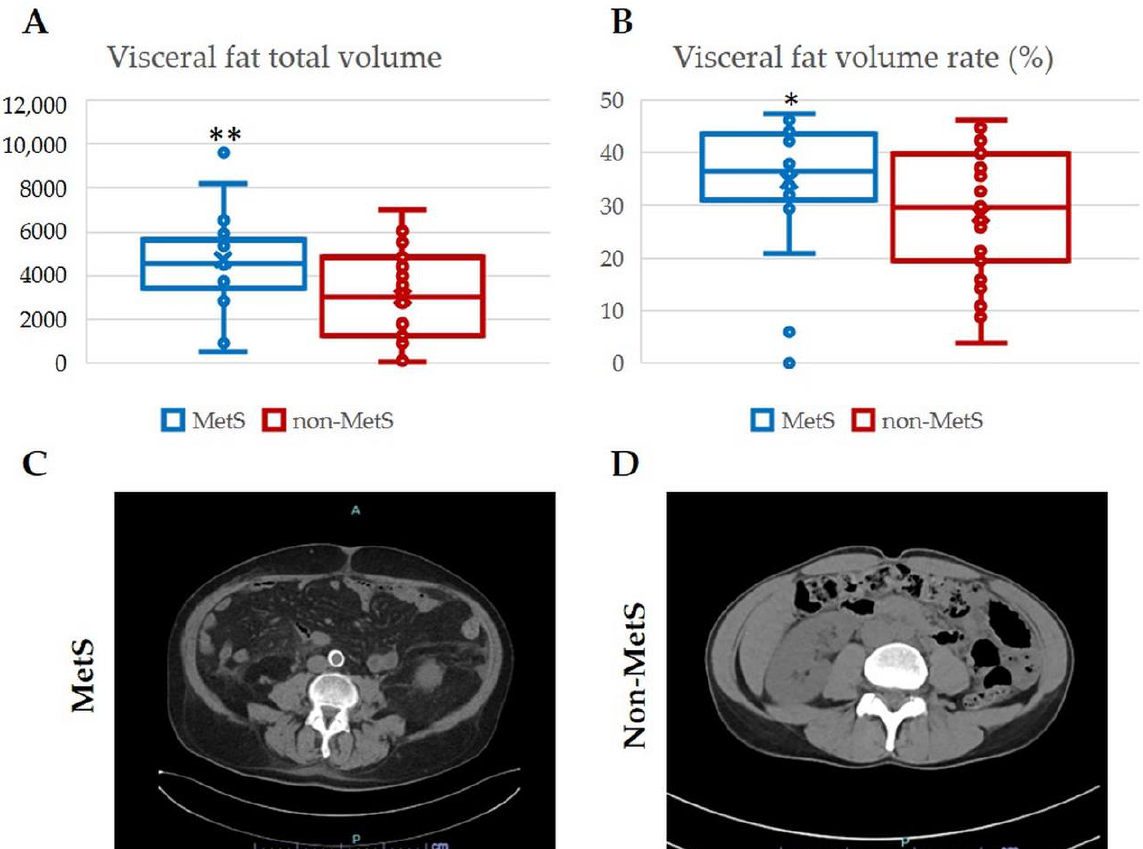
Figure 1. Both visceral fat total volume and visceral fat volume rate were increased in patients with MetS. The volume of visceral fat ( A ) and its percentage ( B ) were significantly increased in MetS with respect to non-MetS iCCA patients. ( C , D ) Representative CT scan images of MetS and non-MetS iCCA showing different visceral fat accumulation between the two groups. Measurement was performed by abdominal CT scan. * p < 0.05 vs. non-MetS; ** p < 0.01 vs. non-MetS using 2-tailed t test.